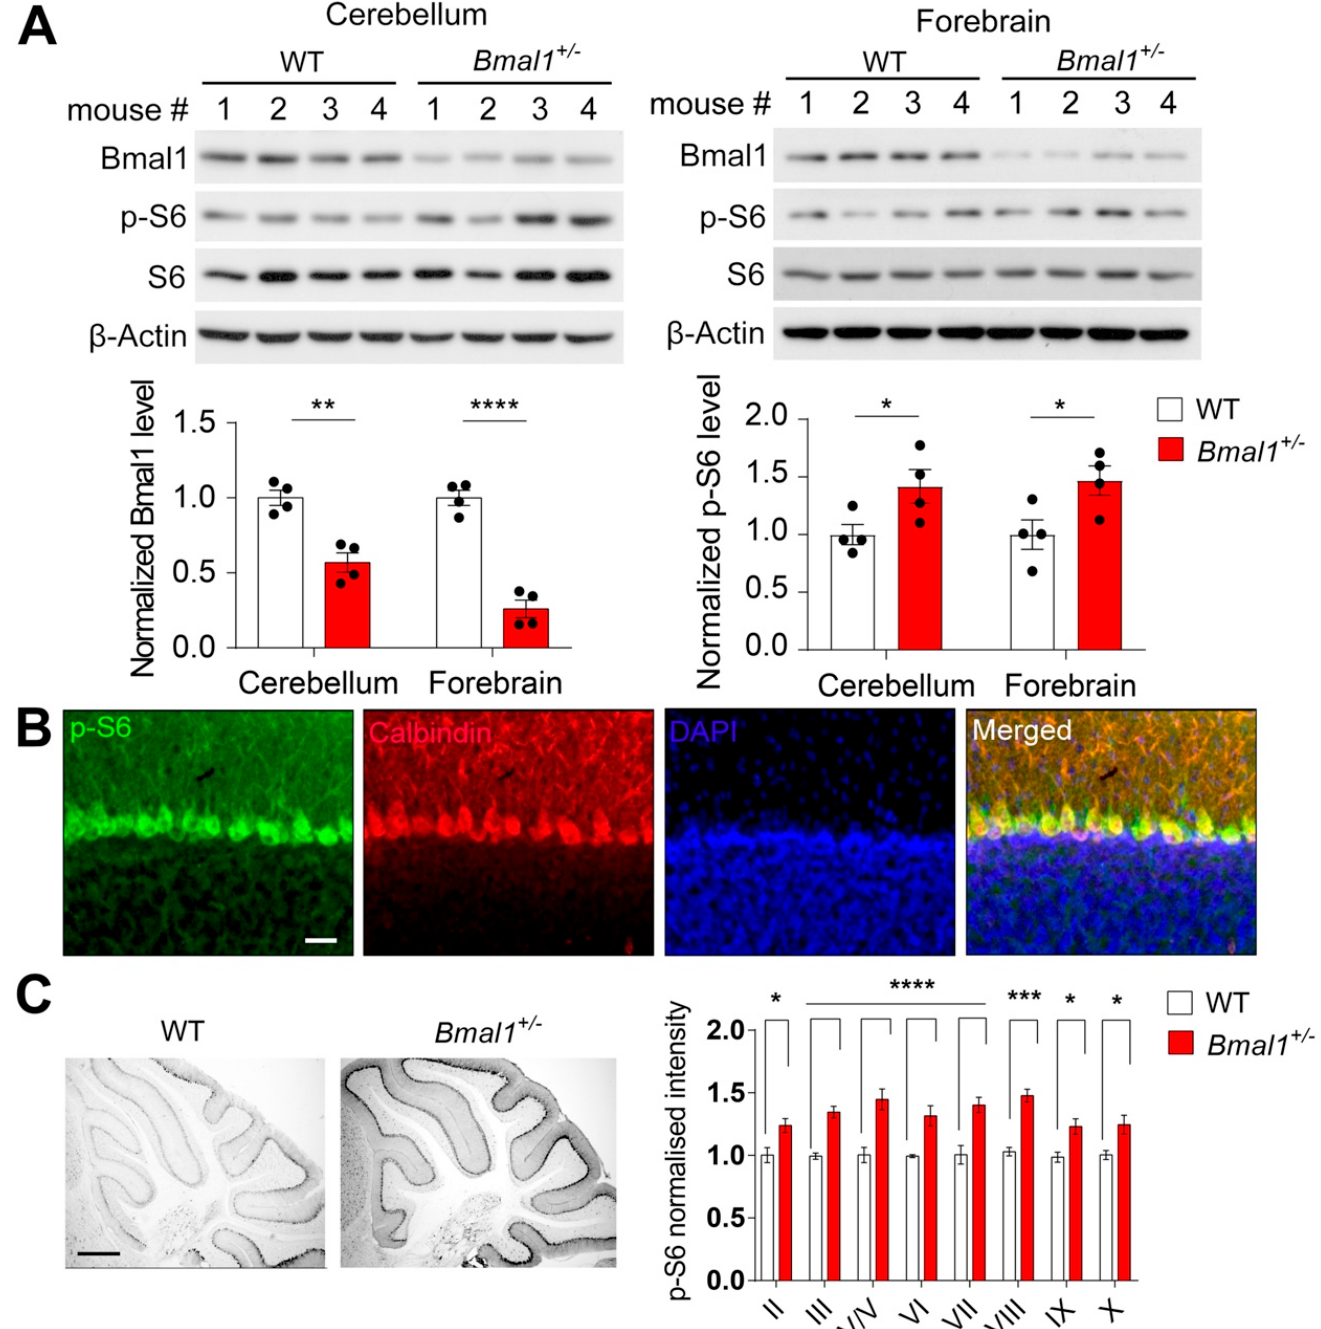
Figure 1. Heterozygous Bmal1 mutation leads to decreased Bmal1 expression and increased mTOR activation in the mouse brain . ( A ) Haploinsufficiency of Bmal1 expression and brain-wide mTOR hyperactivation in Bmal1 +/ − mice. Top: Representative Western blots indicating decreased Bmal1 protein levels and increased phospho-S6 levels in the cerebellum (left) and forebrain (right) of the Bmal1 +/ − mice. β -actin was used as a loading control. Bottom: Bar graphs indicate the quanti- fication of Bmal1 protein levels (left) (cerebellum: t (6) = 5.279, p =0.0019; forebrain: t (6) = 9.553, p < 0.0001, Student’s t -test) and phospho-S6 protein levels (right) (cerebellum: t (6) = 2.455, p = 0.0495; forebrain: t (6) = 2.619, p = 0.0396, Student’s t -test). n = 4 mice/group. ( B ) Confocal microscopic images of mouse cerebellar sections immunolabeled for phospho-S6 (p-S6, green) and Calbindin-D (28k) (red). Cell nuclei were counterstained by DAP1 (blue). Scale bar = 20 µm. ( C ) mTOR hyperactivation in the cerebellum of Bmal1 +/ − mice. Left: Representative bright field microscopic images of sagittal mouse cerebellar sections immunolabeled for phospho-S6 as an indicator of mTOR activities. Scale